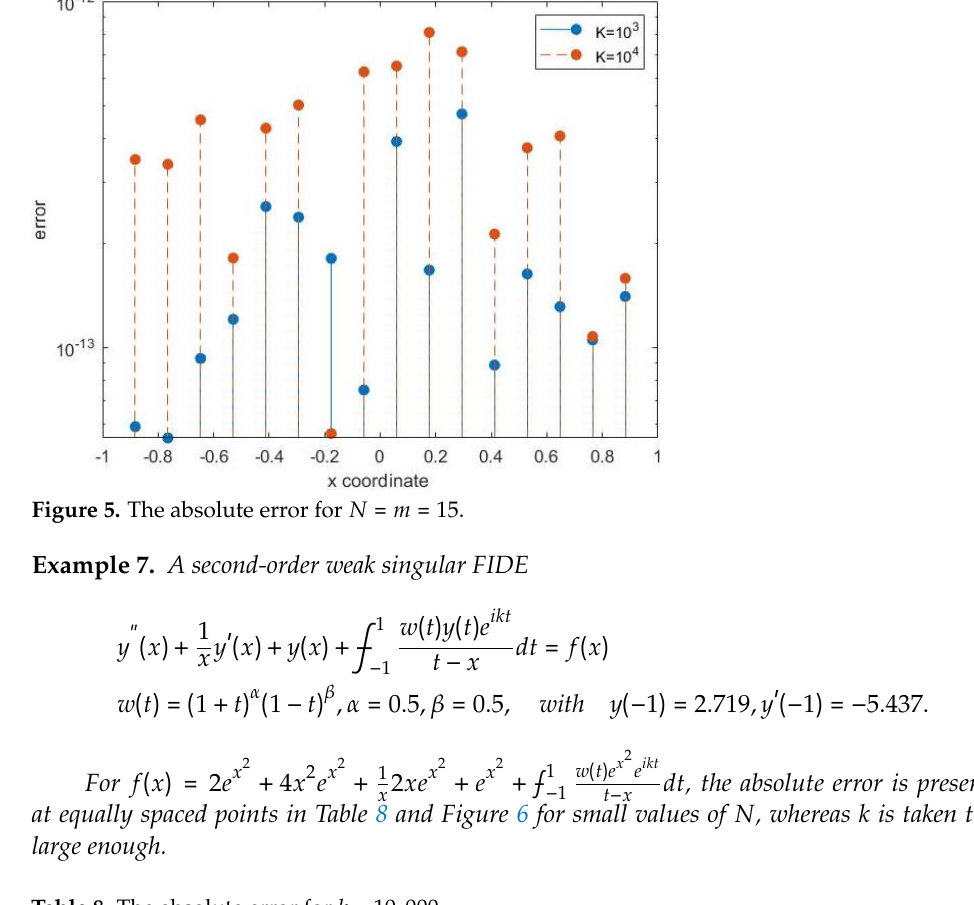
Table 8. The absolute error for k = 10,000.